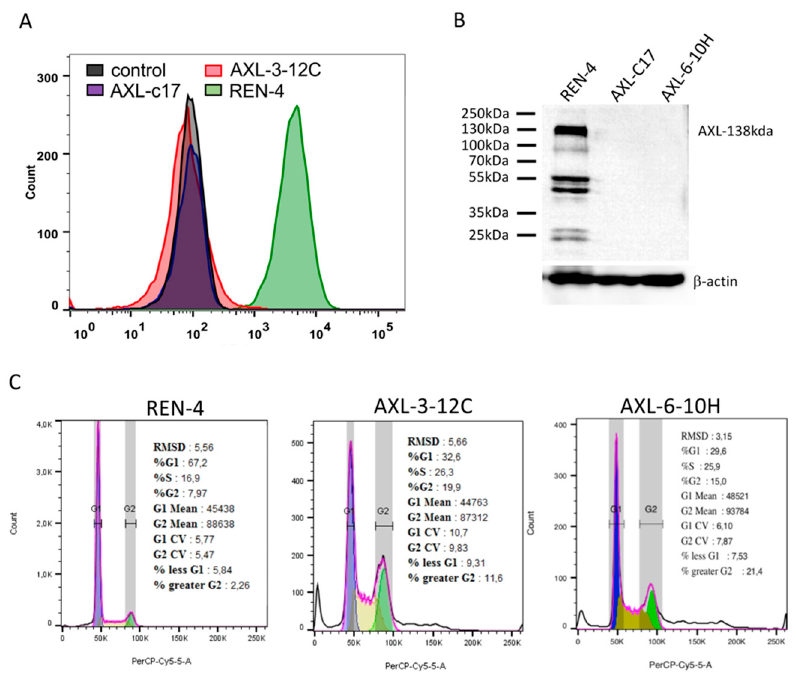
Figure 5. AXL expression and cell cycle analysis of newly obtained AXL knock-out clones, AXL-3- 12C and AXL-6-10H. ( A ) AXL expression in REN-4, AXL-3-12C, AXL-c17 cells were analyzed by flow cytometry. Unstained control cells were used as a negative control. ( B ) AXL expressions of REN-4, AXL-c17, AXL-6-10H were analyzed by western blot. β -actin was used as a loading control. ( C ) Cell cycle distribution of control REN-4 and newly obtained AXL knock-out clones AXL-3-12C, AXL-6-10H, respectively.